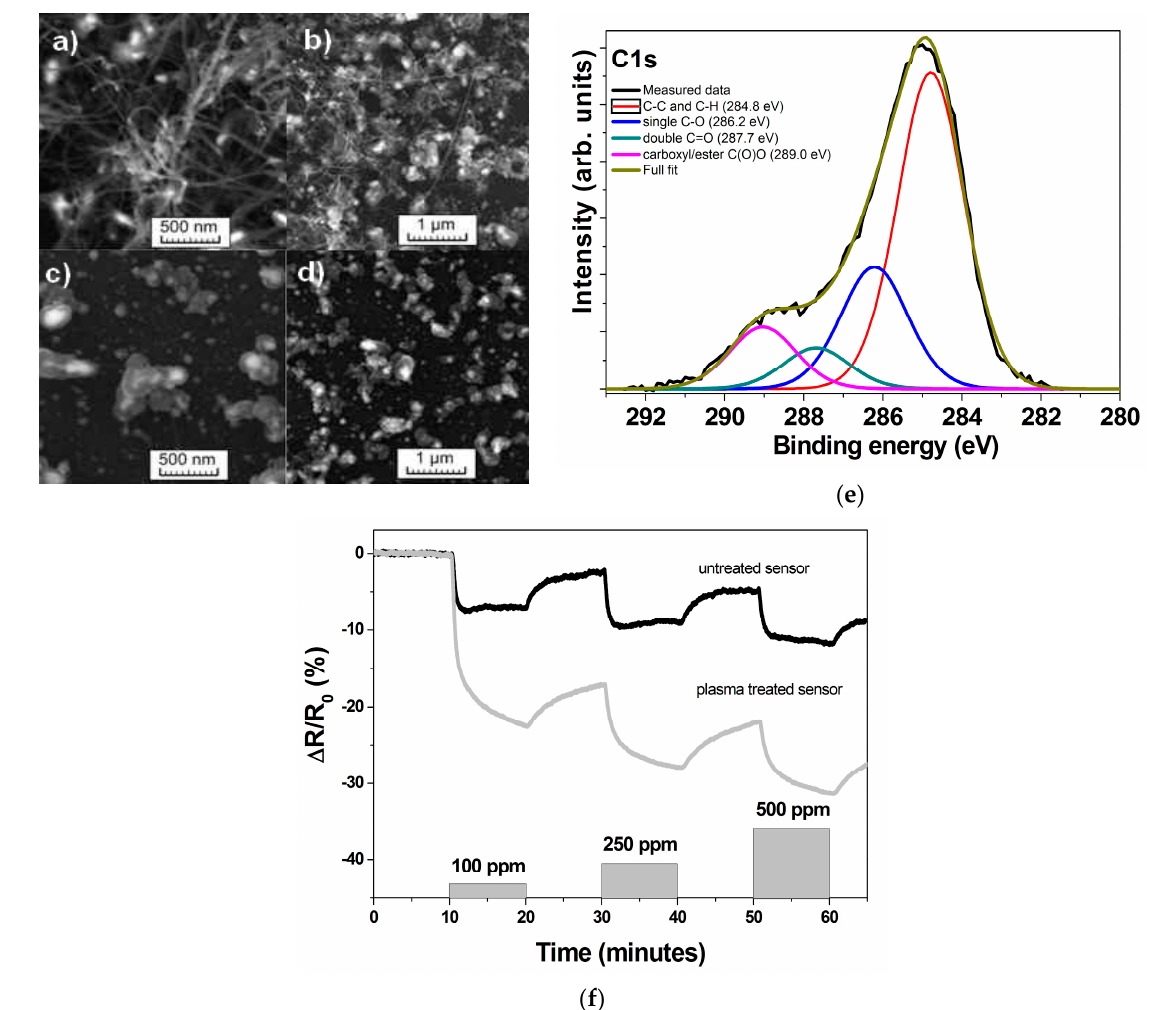
Figure 3. ( a – d ) SEM images of multi-walled carbon nanotubes (MWCNTs) before ( a , b ) and after treatment ( c , d ); ( e ) XPS spectrum of carbon nanomaterial after plasma functionalization; ( f ) Response of plasma functionalized sensor compared to untreated one [142]. With the permission of IEEE.